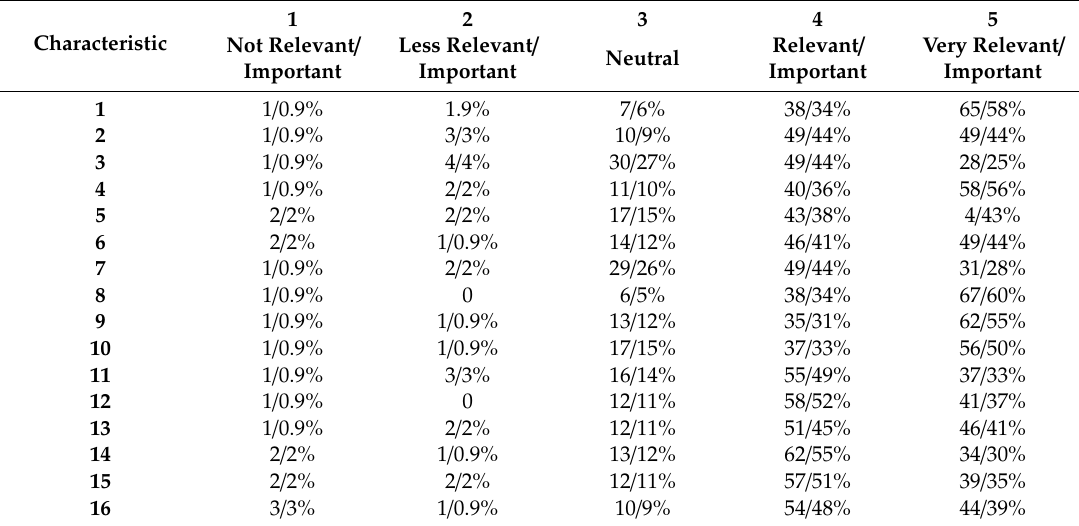
Table 2. Personality characteristics of a